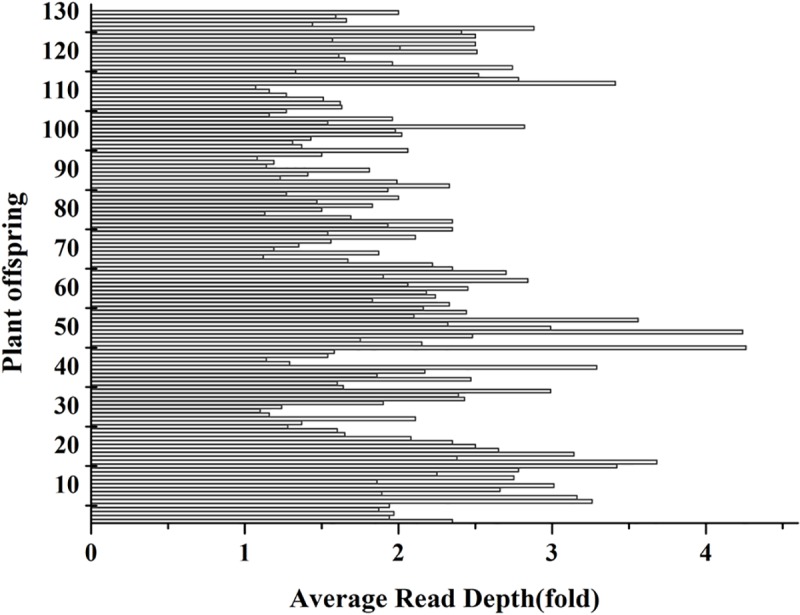
Clean reads number distribution of 130 hybrid offspring.